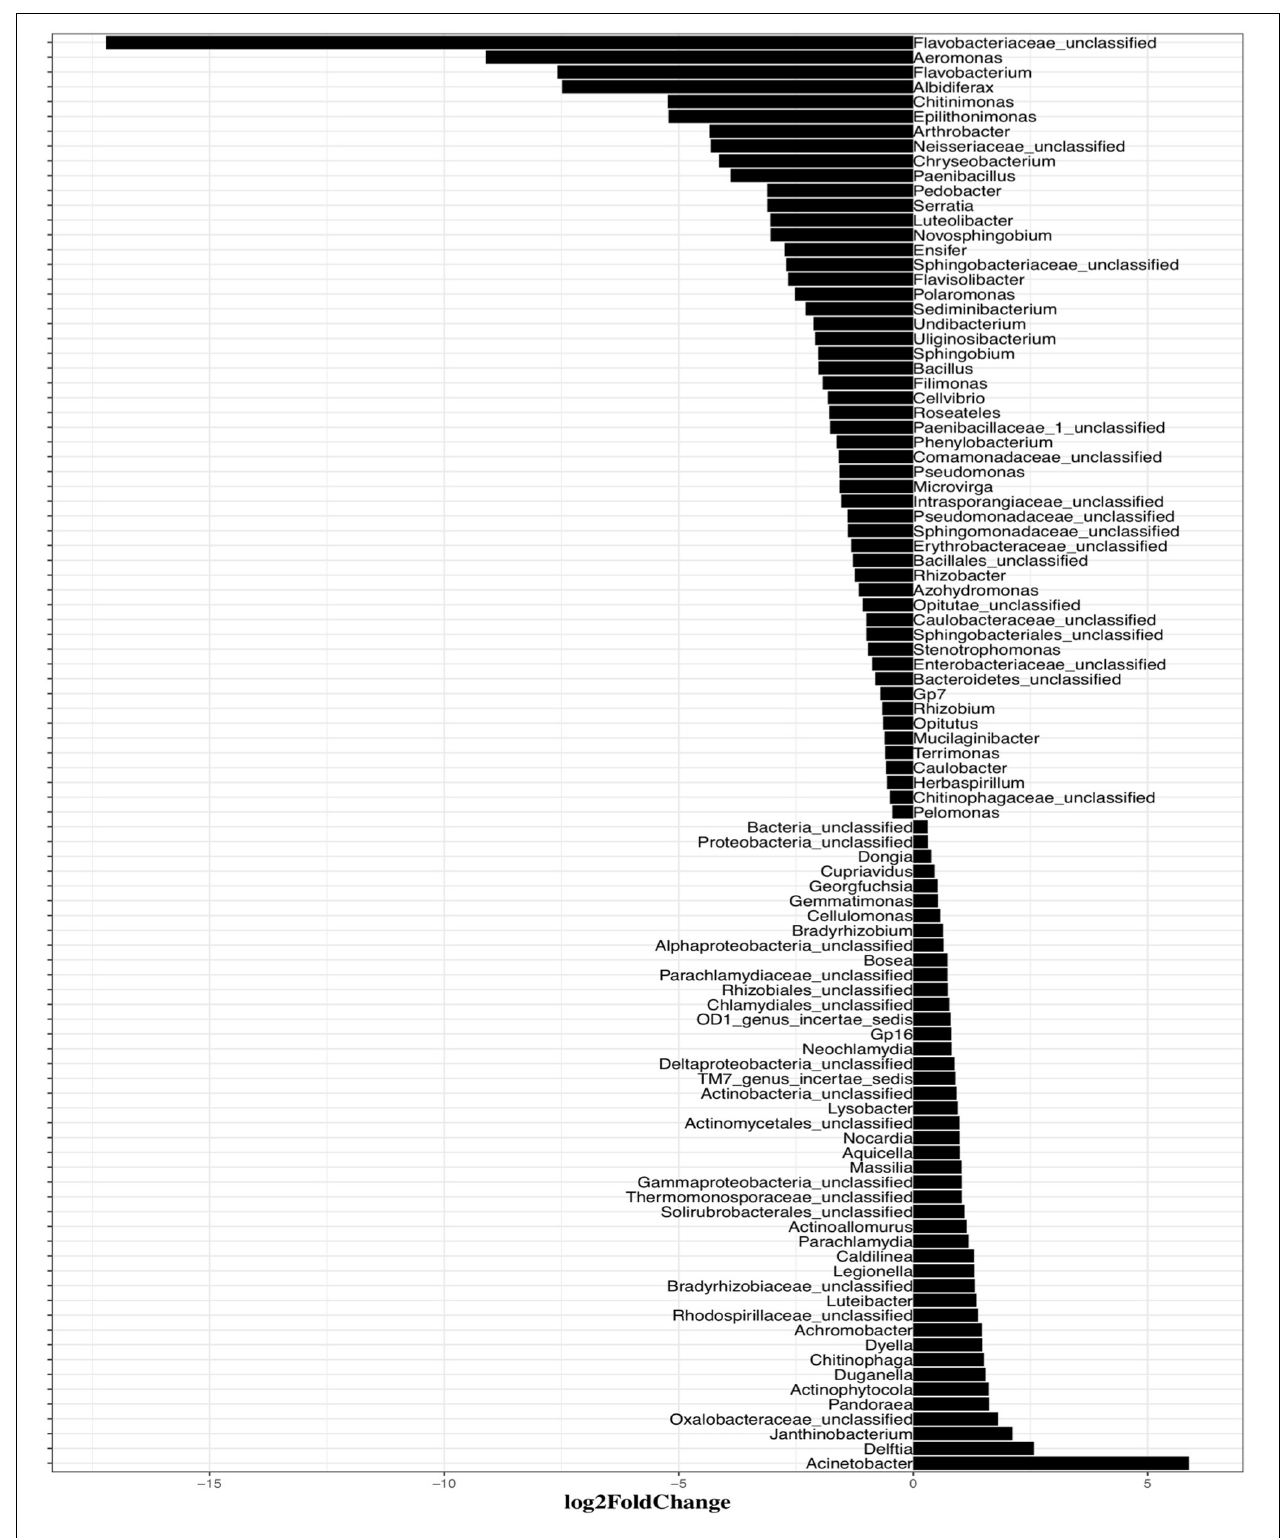
FIGURE 5 | Systematic differences of the bacterial taxonomic composition between induction assay of mitomycin C and the control samples at Genus levels. Only statistically significant differences ( P < 0.01) are shown. The direction of bars represents decreases (left) or increases (right) in relative abundance of the specific bacterial taxonomic groups after the induction